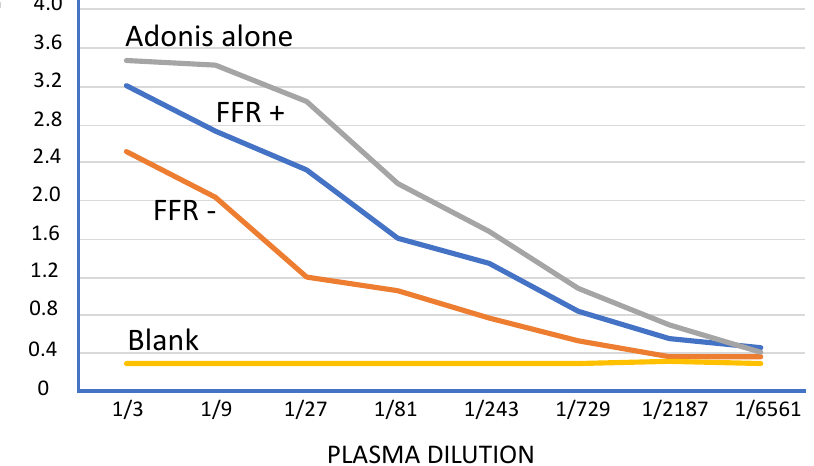
Figure 3. Inhibition ELISA for A 2A R in the plasma of patients. Serial dilution curves obtained with a saturating amount of A 2A R mAb (Adonis) alone and mixed with one representative plasma from patients with FFR <0.8 (FFR+) or without stenosis FFR − (FFR > 0.8). The blank included buffer without A 2A R mAb and plasma. The results are expressed in Absorbance (A) readings at 405 nm and are the mean of the quadruplicates (CV < 10%).